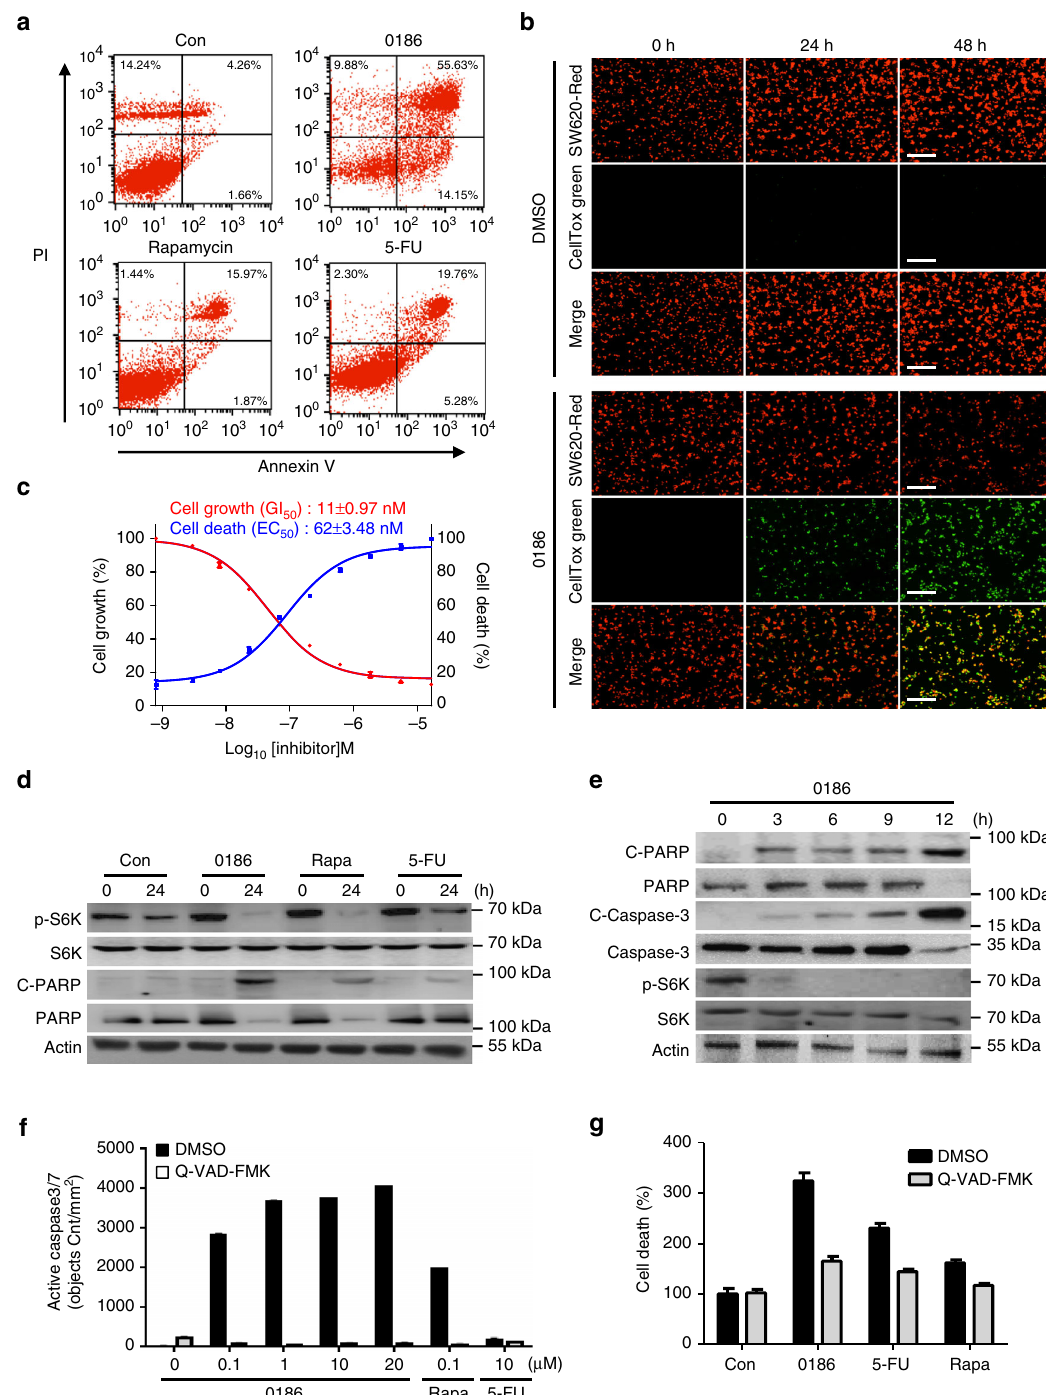
Fig. 5 Effect of BC-LI-0186 on cancer cell death. a SW620 cells were treated with DMSO (Con), rapamycin (100 nM), BC-LI-0186 (10 μ M), or 5-FU (10 μ M) for 24 h. After cells were stained with PI and Annexin V, cells were separated and counted by FACS. b SW620 cells stably expressing RFP were treated with DMSO or 1.85 µ M BC-LI-0186 in the presence of CellTox green. After 0, 24, 48 h, red (cell growth) and green (cell death) fl uorescence images were acquired. c SW620 cells stably expressing RFP were treated with various concentration of BC-LI-0186 in the presence of CellTox green to monitor cell growth and death, simultaneously. The GI 50 ( red line ) and EC 50 ( blue line ) of BC-LI-0186 were determined by analyzing dose-response curves using GraphPad Prism tools. The insets represent the GI 50 and EC 50 values of BC-LI-0186. d SW620 cells were treated with DMSO (Con), BC-LI-0186 (10 μ M), rapamycin (100 nM), or 5-FU (10 μ M) for 24 h. Cells were analyzed by immunoblotting with the indicated antibodies. e SW620 cells were treated with 10 μ M BC-LI-0186 for 0, 3, 6, 9, 12 h and analyzed by immunoblotting with the indicated antibodies. f SW620 cells were treated with DMSO (Con), BC-LI-0186 (0.1, 1, 10, 20 μ M), rapamycin (100 nM), or 5-FU (10 μ M). After 24 h, apoptosis was measured using Cellplayer caspase-3/7 reagent in the absence or presence of Q-VAD-FMK, which is an apoptosis inhibitor. g SW620 cells were treated with DMSO (Con), BC-LI-0186 (10 μ M), rapamycin (100 nM), or 5-FU (10 μ M) in the presence of CellTox green to measure cell death. After 24 h, green fl uorescence was monitored in the presence of Q-VAD-FMK. The error bars represent mean ± S.D. ( n =